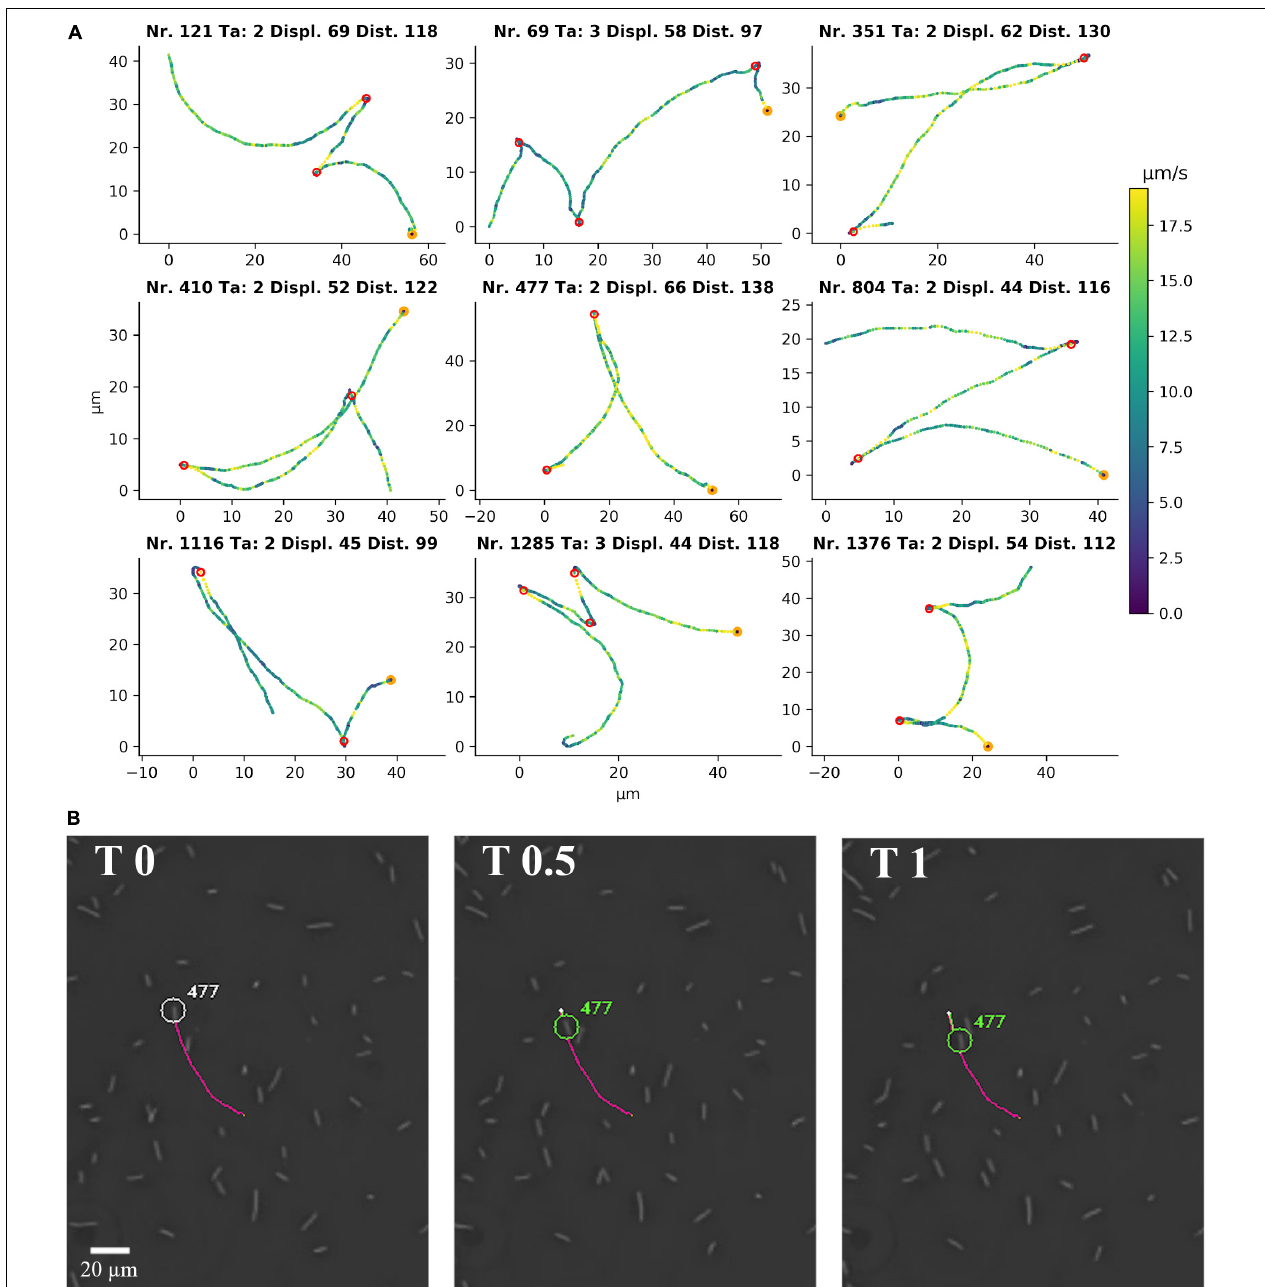
FIGURE 3 | Single cell motility of C. difficile 630 (cid:49) erm in 1.8% PVP. (A) Representative single cell tracks from Supplementary Movie 4 as detected by YSMR. Titles denote track number, number of turnarounds (Ta), displacement (Displ., µ m), and total distance covered (Dist., µ m). Colour of the positions indicates current speed in µ m/s, with a colour bar on the right for reference. The start of the track is marked in orange. Red circles show the calculated positions of turnarounds. The bacteria associated with the displayed tracks are labelled in Supplementary Movie 4 . The formation of tracks is shown in Supplementary Movie 4 by the extension of a coloured line behind the respective bacterium. (B) A picture sequence taken from Supplementary Movie 4 shows the first turnaround of track number 477, starting with the turnaround itself (T 0 s) and images at 0.5 and 1 s after the turnaround. The picture sequence shows the start of the backward movement without previous reorientation at the